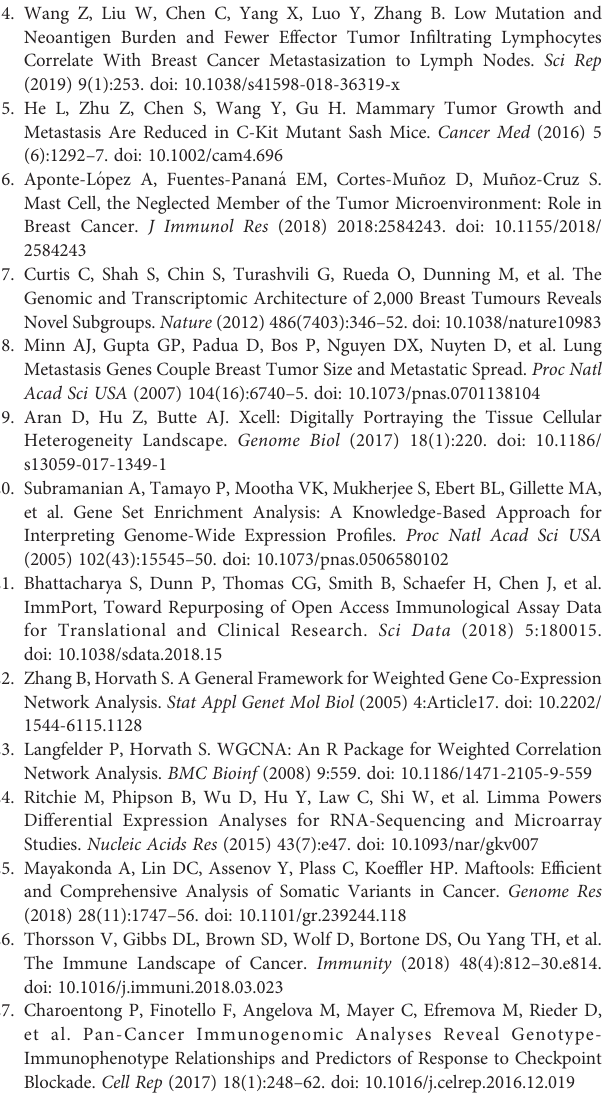
Supplementary Figure 2 | Comparison of the mRNA expression fold changes of immune-related genes and chemokines. Supplementary Figure 3 | Immunogenicity of breast cancer patients with or without lung metastasis in the TCGA cohort. Supplementary Figure 4 | Neoantigens of breast cancer patients with lung metastasis. Supplementary Figure 5 | GSEA analysis of breast cancer patients in the GSE2603 cohort. Supplementary Figure 6 | Mast cell fraction and survival. Supplementary Figure 7 | Correlation between pro-metastasis IRGs and mast cell